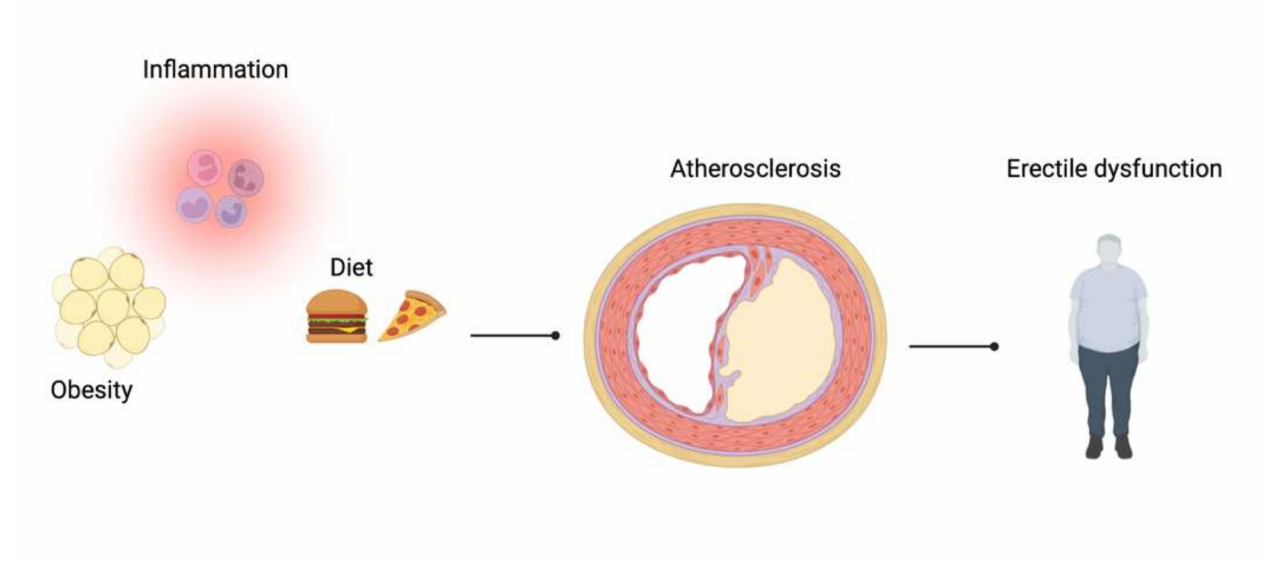
Figure 1. Overview of mechanisms associated with erectile